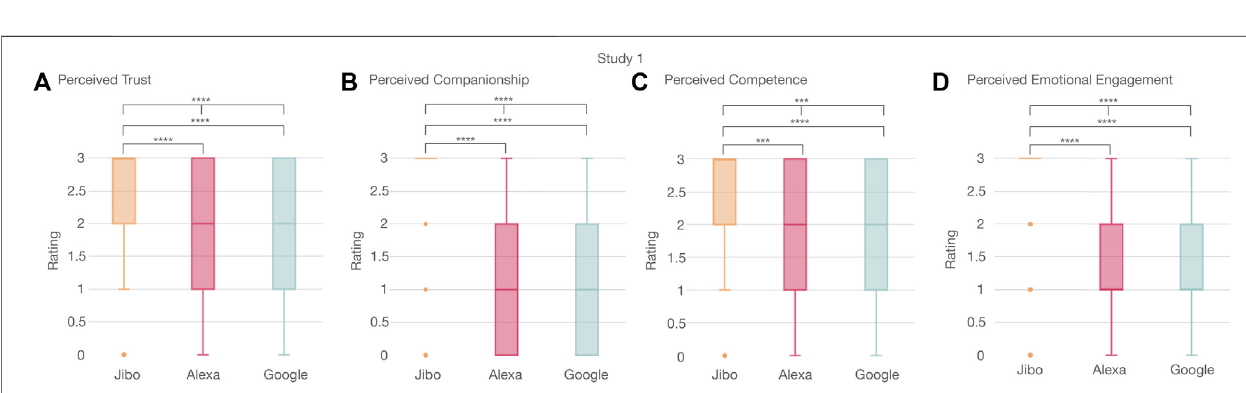
Frontiers in Robotics and AI |